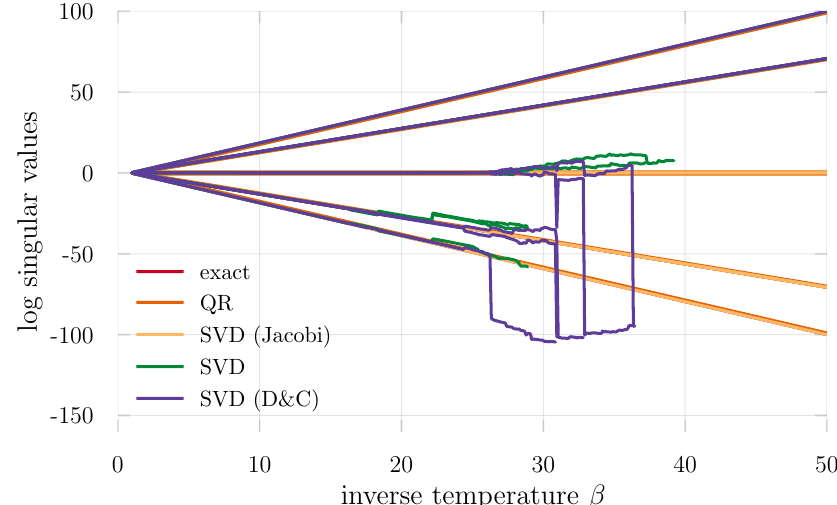
Figure (2) Comparison of matrix decompositions to heal the numerical insta- bilities in the calculation of the time slice matrix chain product B model (7). Different lines represent logarithmic singular values as observed in sta- bilized computations. The QR (orange) and Jacobi SVD singular values (yellow) lie on top of the exact result (red) whereas both the regular SVD (green) and the divide-and-conquer SVD (purple) show large deviations at low temperatures β (cid:166) 25 ( ∆ τ =